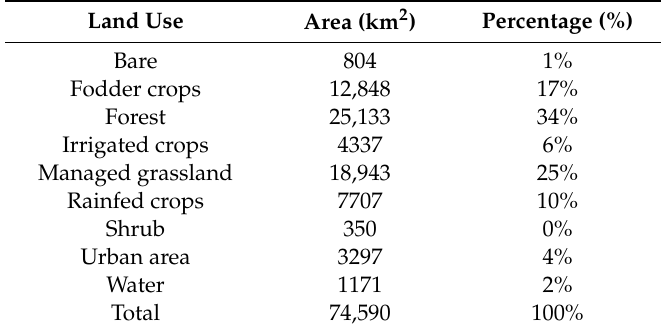
Table 1. Land cover classes distribution in the Po River Basin. Land Use Area (km 2 ) Percentage